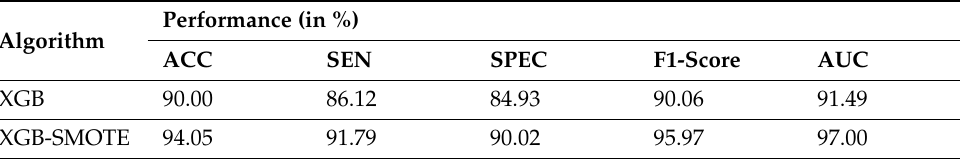
Table 2. Performance analysis using XGB using hold-out cv.